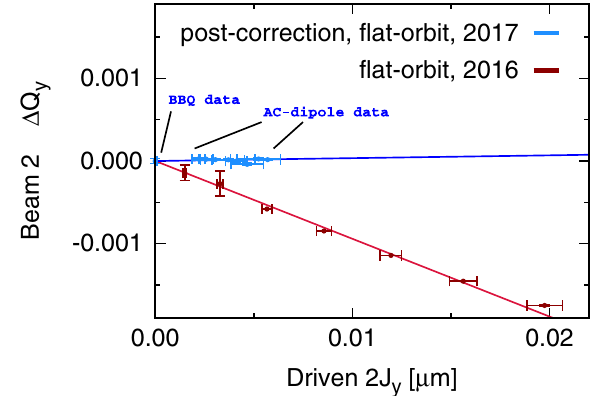
FIG. 10. Example of amplitude detuning measurements at β (cid:1) ¼ 0 . 3 m after IR-octupole correction (blue), and β (cid:1) ¼ 0 . 4 m before correction (red).